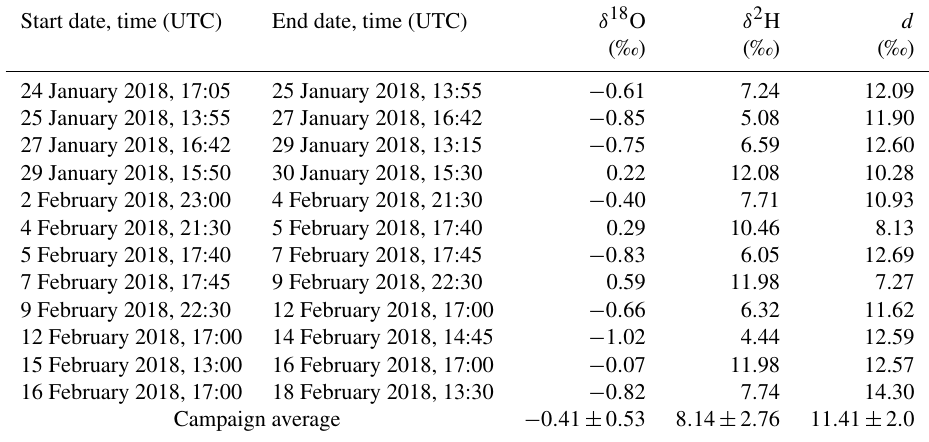
Table 4. Isotope composition of precipitation events sampled with a totalisator from PALMEX. The samples were measured using a cavity ring-down laser spectrometer and normalised to the official IAEA VSMOW–SLAP scale. The analytical precision of the measurements is 0.16‰ for δ 18 O and 0.6‰ for δ 2